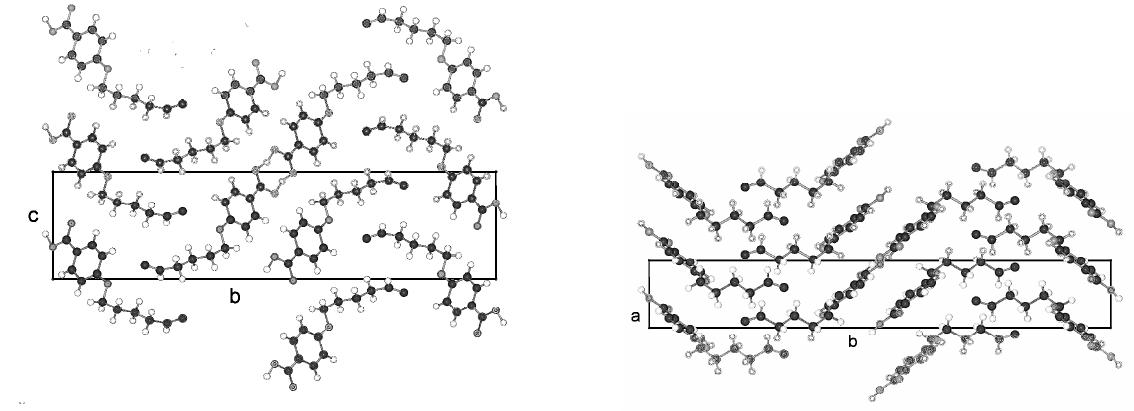
Figure 14. Representation of the packing arrangement in space group P2 4-(hex-5-enoxy)benzoic acid (HOBA) in two projections along [100] and